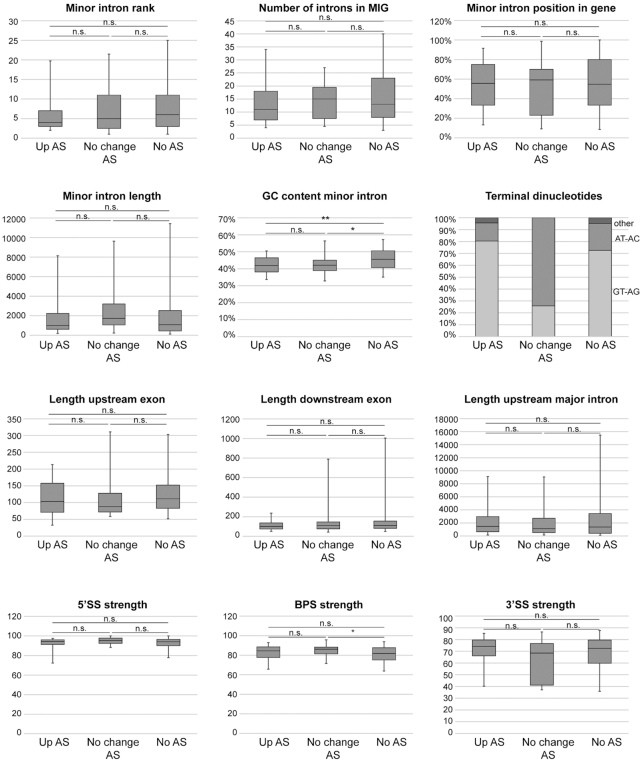
Alternatively spliced minor introns have a lower GC content than canonically spliced minor introns. Boxplots showing the 5th to 95th percentiles of several intronic and gene features for minor introns that show elevated AS upon U11 loss (up AS; 46 introns), no change in AS upon U11 loss (no change AS; 31 introns) or are not alternatively spliced at all (no AS; 631 introns). Statistical significance was determined by the Kruskal–Wallis test, followed by the post-hoc Dunn test. n.s. = not significant; *P < 0.05; **P < 0.01.